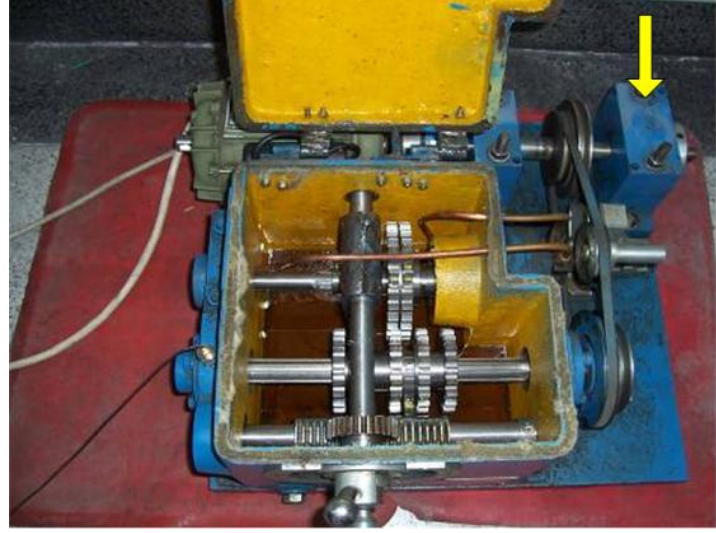
Figure 3. Bearing test rig. Table 2. The experiment parameter and failure frequency of bearing.